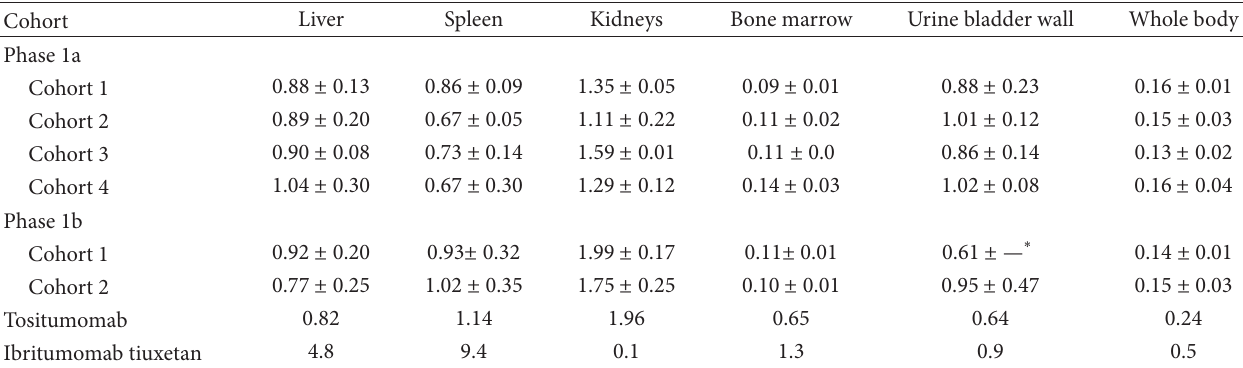
Re-6D2: (a) change from baseline of SUV ; (b) change and 30 represent the separation from stable 188 max % % % − %